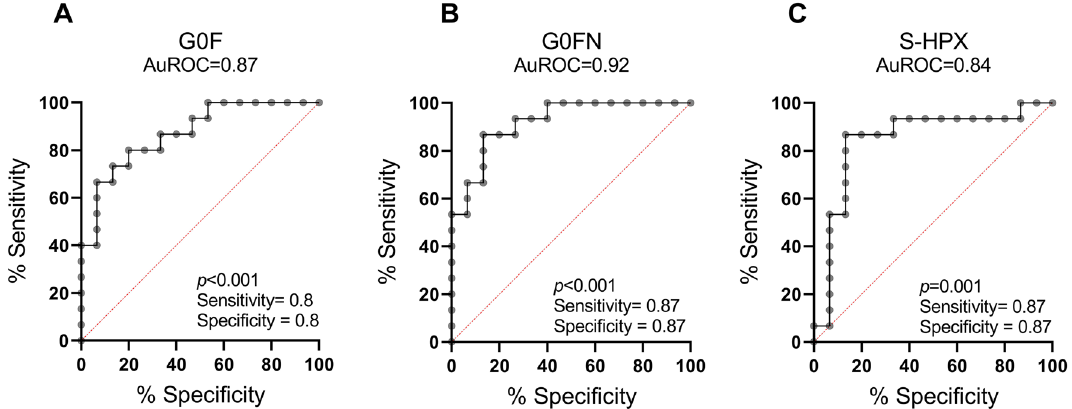
Figure 5. AuROC analyses of the IgG glycoforms G0FN ( A ) and G0F ( B ) between the liver fibrosis and control groups, and of the S-HPX ( C ) between the fibrosis and cirrhosis